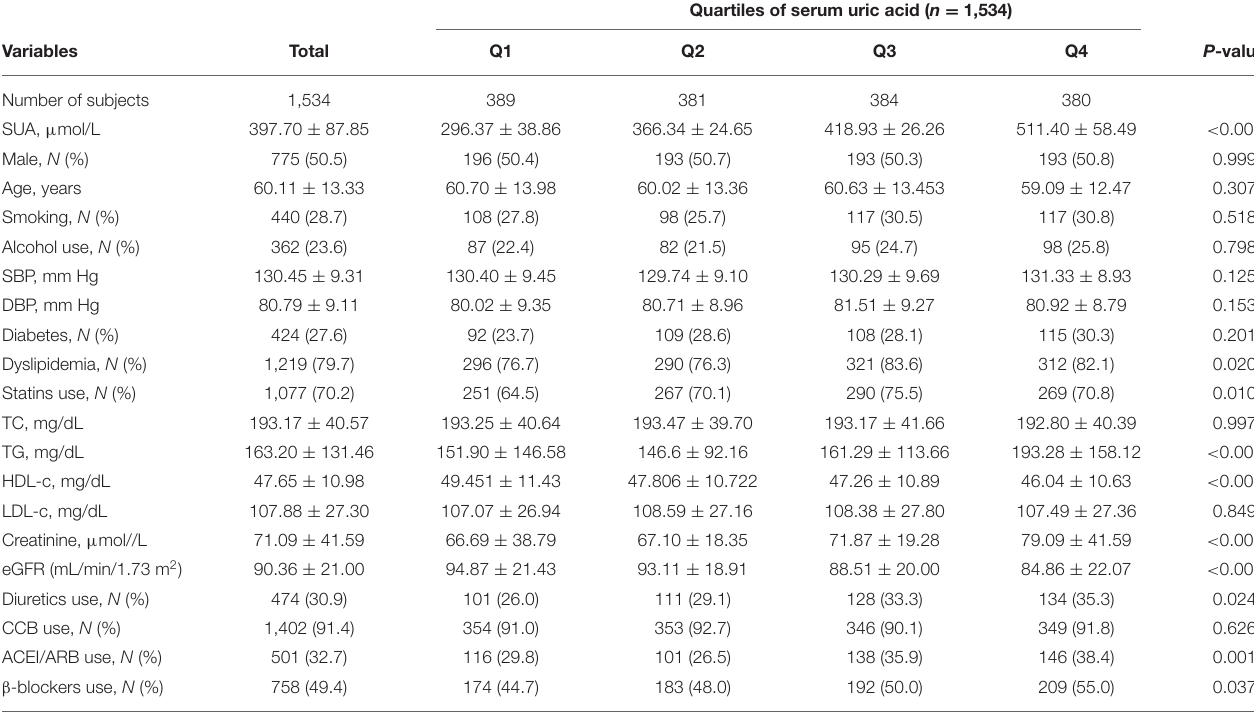
Quartiles of serum uric acid ( n =